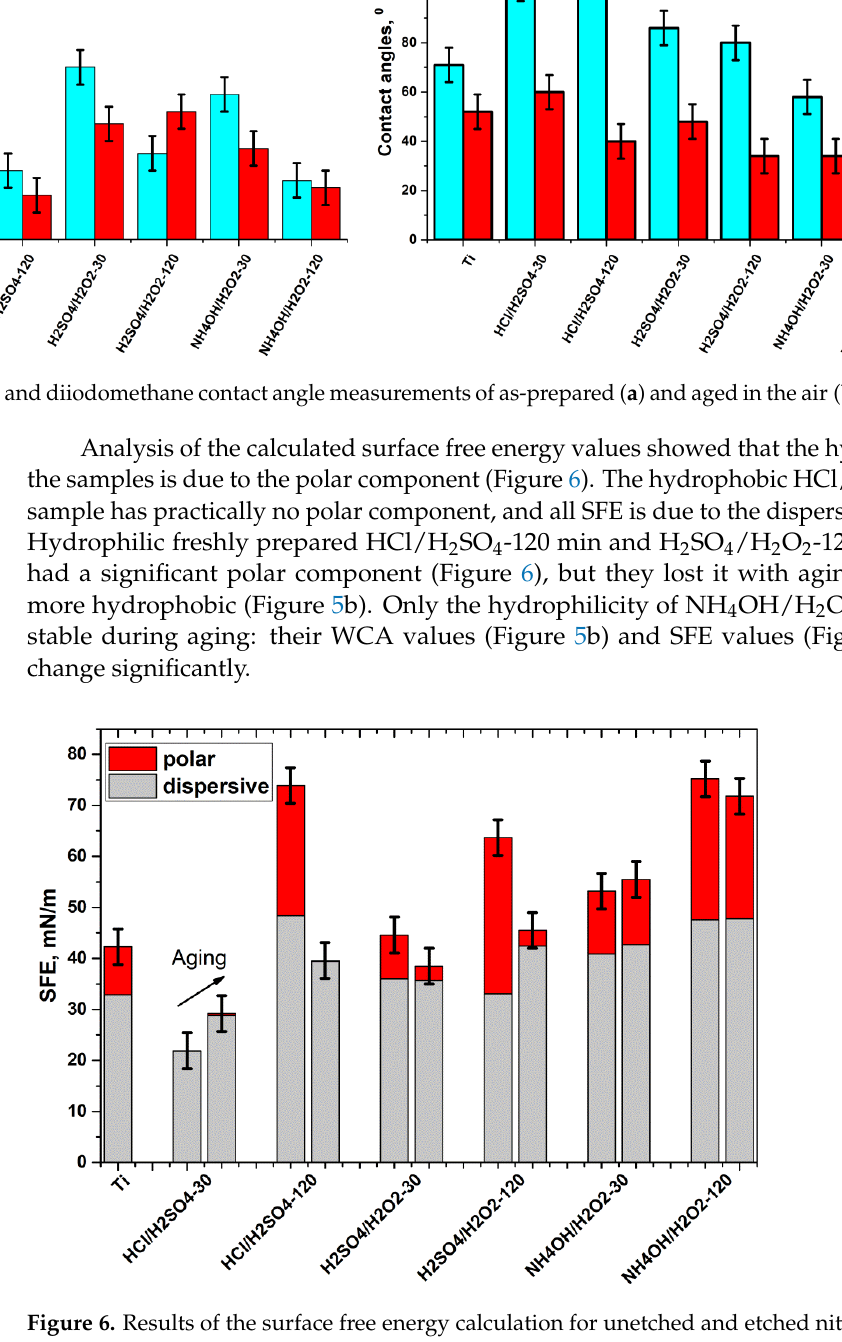
Figure 6. Results of the surface free energy calculation for unetched and etched nitinol.